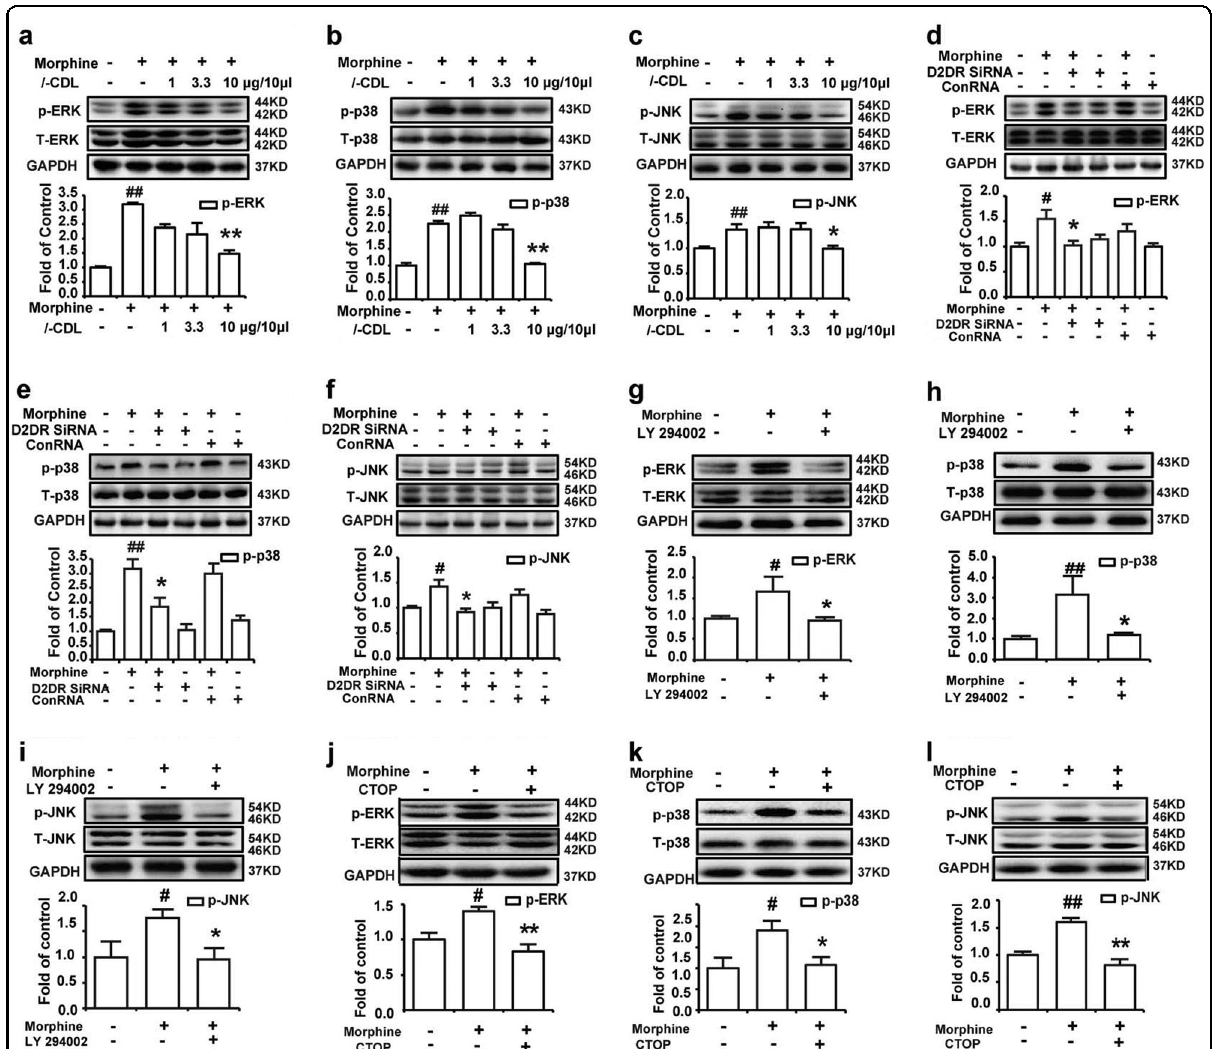
Fig. 6 l- CDL antagonizes spinal D2DR to attenuate morphine tolerance in mice through PI3K/Akt-MAPK signaling in a MOR-dependent manner. a – c Western blots showing increased levels of p-ERK1/2, p-p38, and p-JNK in the spinal cord after chronic morphine treatment, changes that were signi fi cantly decreased by the intrathecal administration of l- CDL. d – f Mice receiving a spinal D2DR siRNA injection with a morphine infusion showed a signi fi cant reduction in the levels of p-ERK1/2, p-p38, and p-JNK in the spinal cord. g – i Inhibition of spinal PI3K with its inhibitor LY 294002 also decreased the levels of p-ERK1/2, p-p38, and p-JNK in the spinal cord. j – l Intrathecal administration of the MOR antagonist CTOP (1 ng/ 10 μ l) reversed the increased levels of p-ERK1/2, p-p38, and p-JNK in the spinal cord. Representative western blot bands and a summary of the data are shown. All spinal cords were collected on day 7, 30 min after chronic morphine exposure. Data are presented as means ± SE. n = 4, # P < 0.05, ## P < 0.01, compared with the control group; * P < 0.05, ** P < 0.01, compared with the morphine